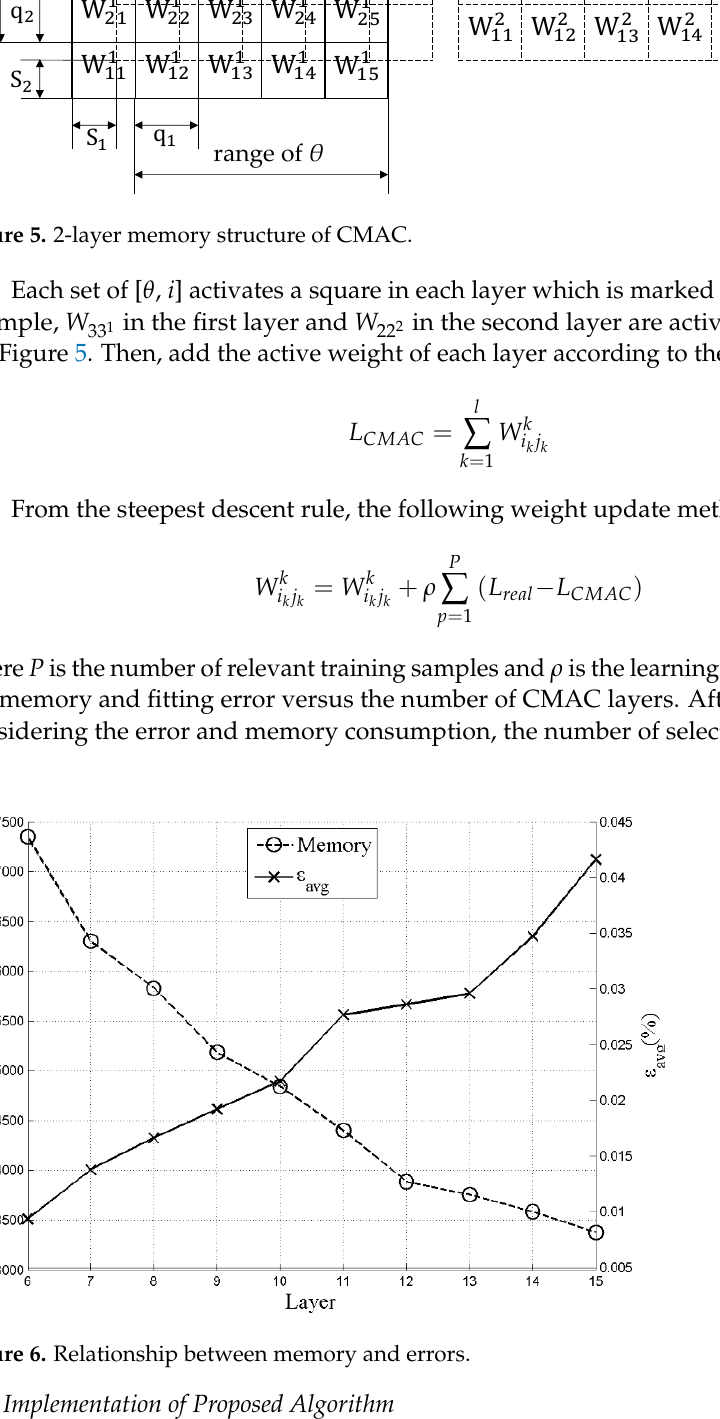
Figure 7. Torque plan waveform. In Figure 7, θ is the rotor position angle of the first phase. For a single phase, it is necessary to find the rotor position angle corresponding to the current i max and the torque 0.5 T * (1 N), as indicated by the circle in the figure. In this way, two angles can be found, and the one close to − 30° is recorded as θ 1 , while the one close to 0° is recorded as θ 2 , and then the torque is initially planned according to Formula (12):